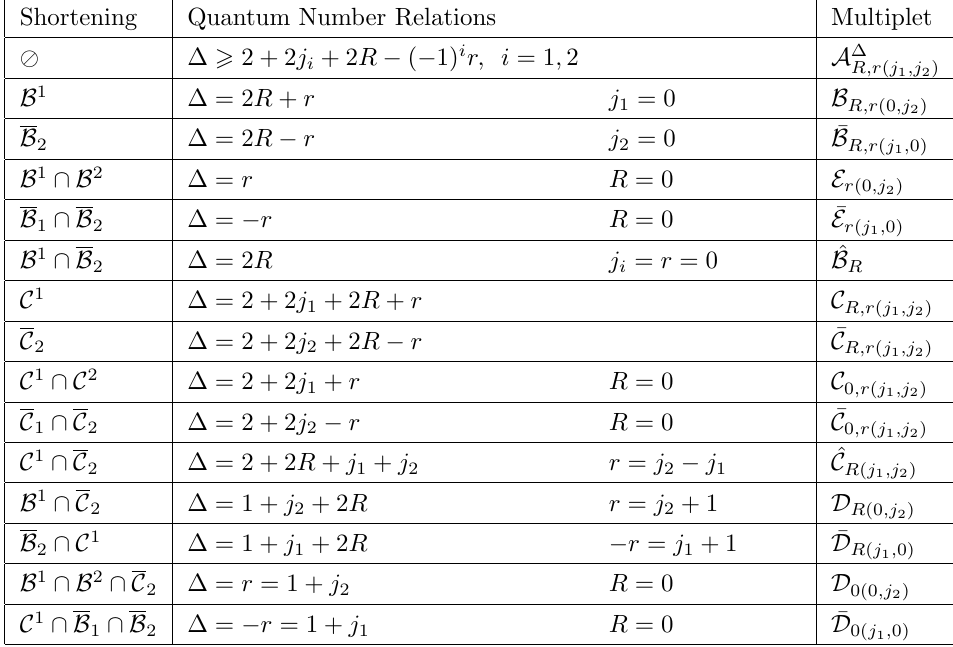
Table 1 . Classi(cid:12)cation of the unitary irreducible representations of the N = 2 superconformal